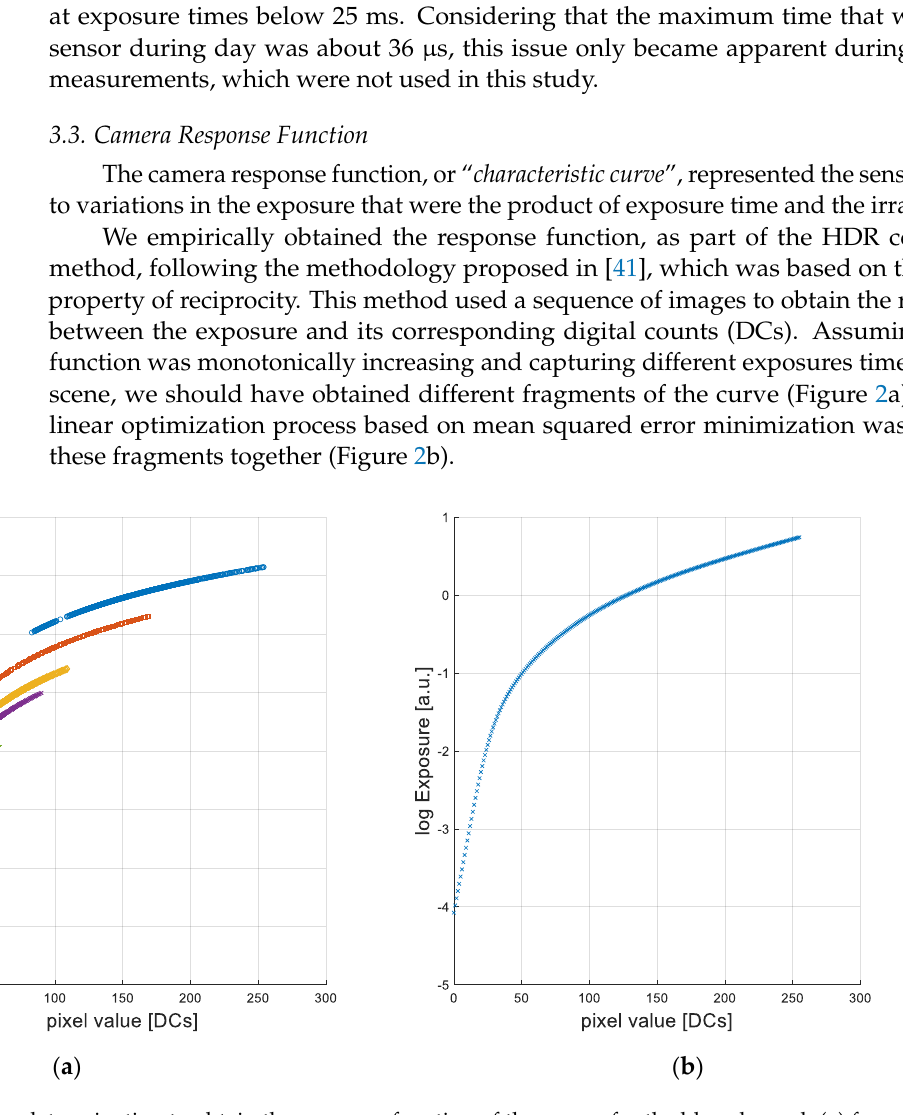
Figure 2. Example of the determination to obtain the response function of the sensor for the blue channel: ( a ) fragments of the characteristic curve at nine exposition times; ( b ) the fitting characteristic curve.